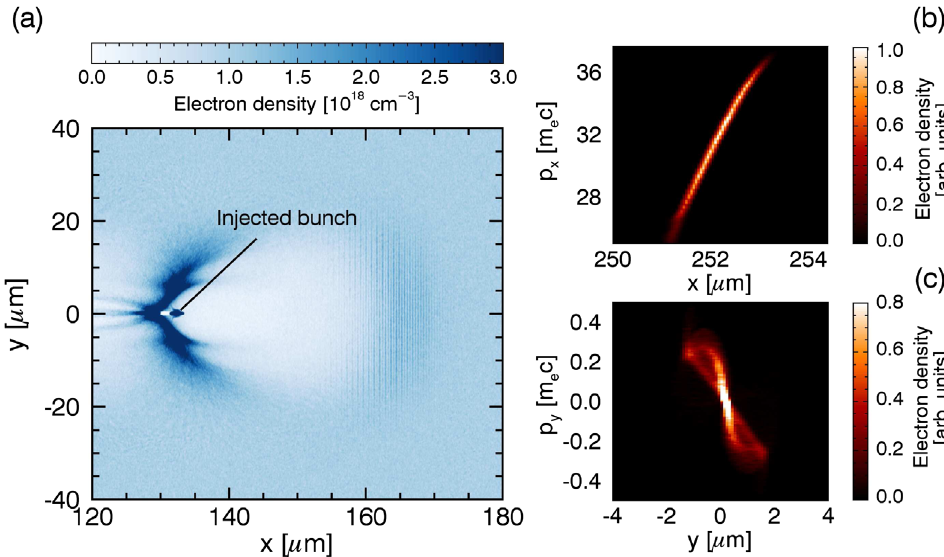
FIG. 3. 3D simulation results for DPCI. (a) Electron density distribution on the z ¼ 0 plane at t ≈ 600 fs. (b) Electron longitudinal phase-space distribution at t ≈ 1 . 00 ps. (c) Electron transverse phase-space distribution at t ≈ 1 . 00